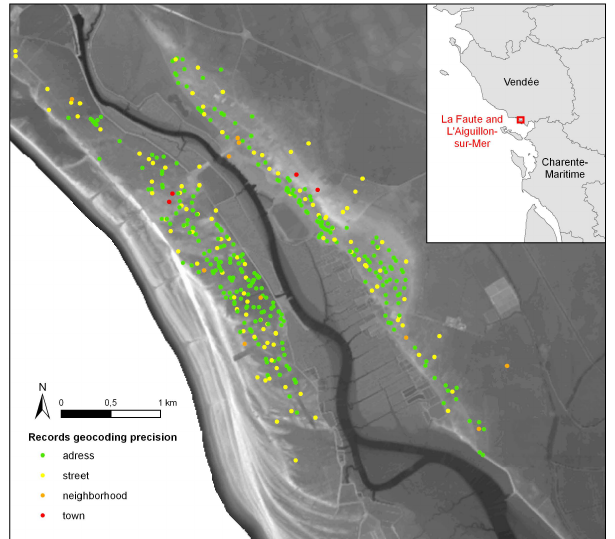
Fig. 2. Map showing the density of damage records for the towns of La Faute-sur-Mer and L’Aiguillon-sur-Mer in the French Vend´ee Department for the three insurance companies that took part in the study. The resulting dataset is believed to represent around 25% of the overall insurance market in France. The colour scale indicates the geocoding